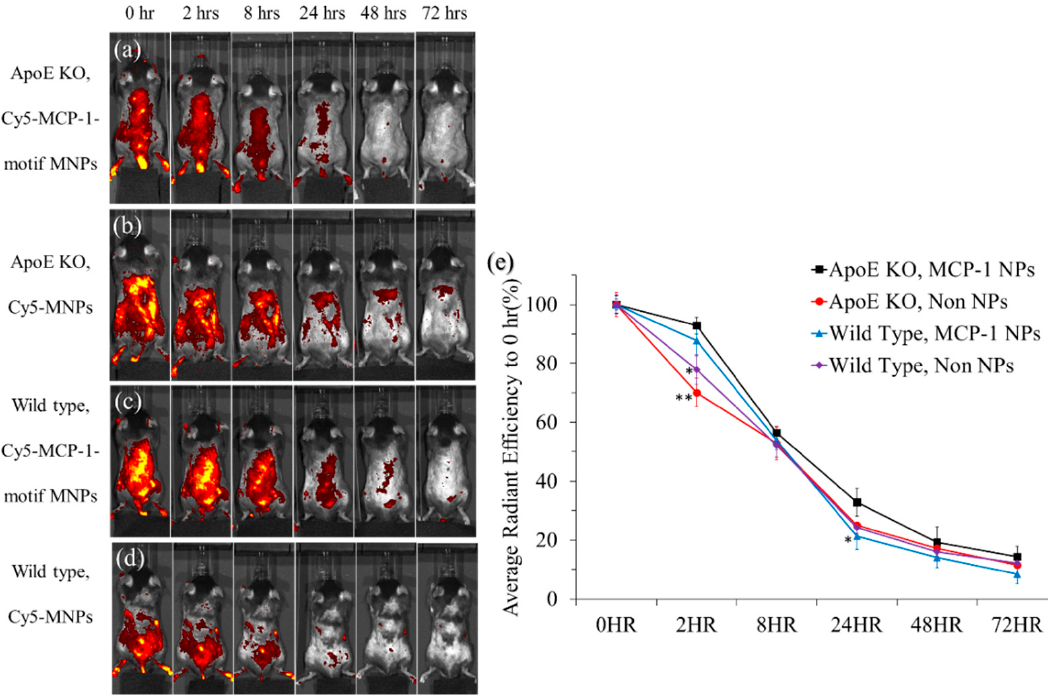
Figure 8. ( a – d ) IVIS body fluorescence of ApoE KO mice, wild-type mice injected with Cy5-MCP-1-motif MNPs and Cy5-MNPs; ( e ) average radiant efficiency at 0 h of IVIS body fluorescence ( n = 3) (* p < 0.05 compared with ApoE KO, MCP-1 NPs at the same injection time; ** p < 0.01 compared with ApoE KO, MCP-1 NPs at the same injection time).